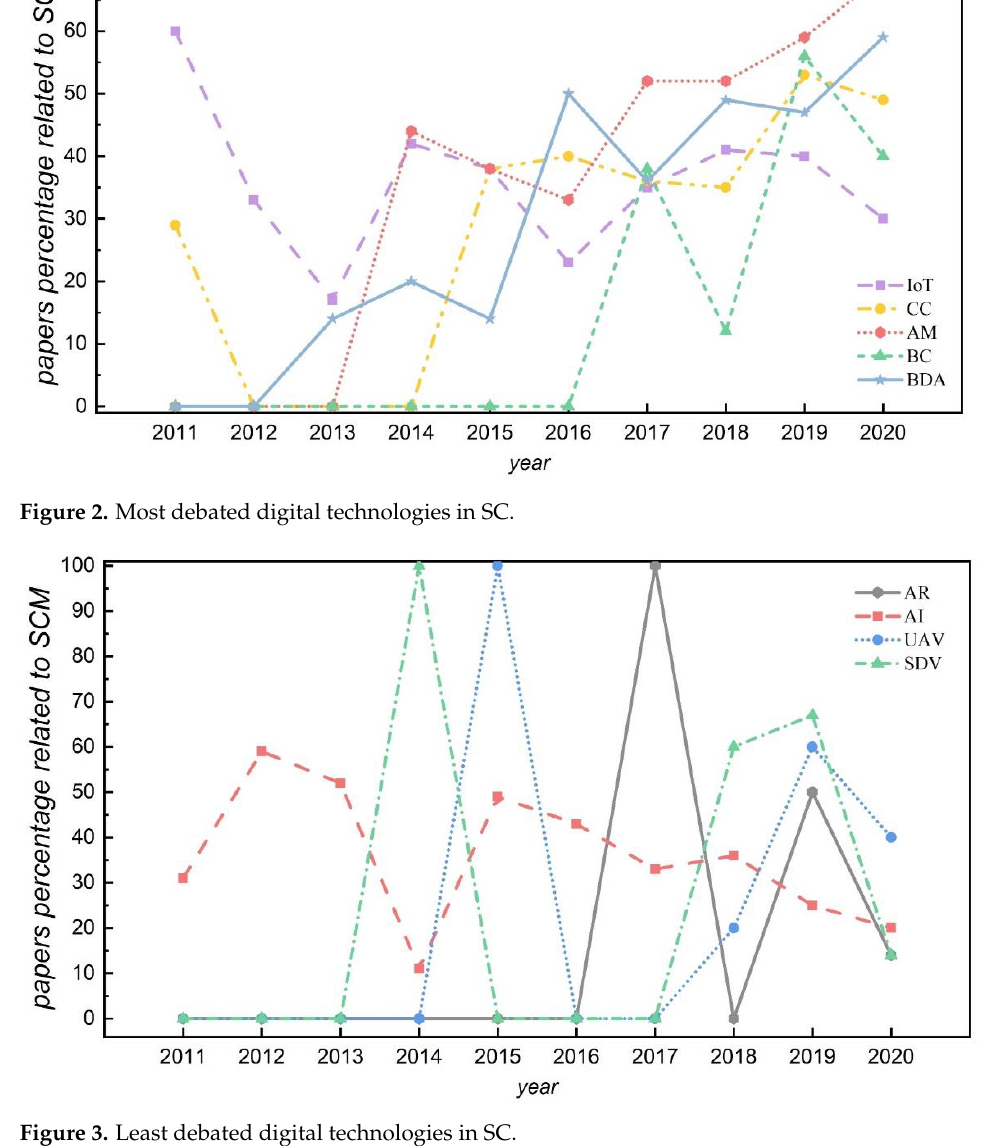
Figure 3. Least debated digital technologies in SC .